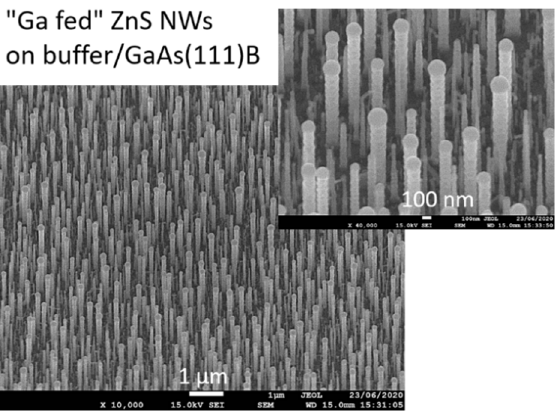
Figure 14. SEM images of ZnS NWs on ZnS (buffer)/GaAs (111)B, using “Ga ‐ fed” Au ‐ droplets.